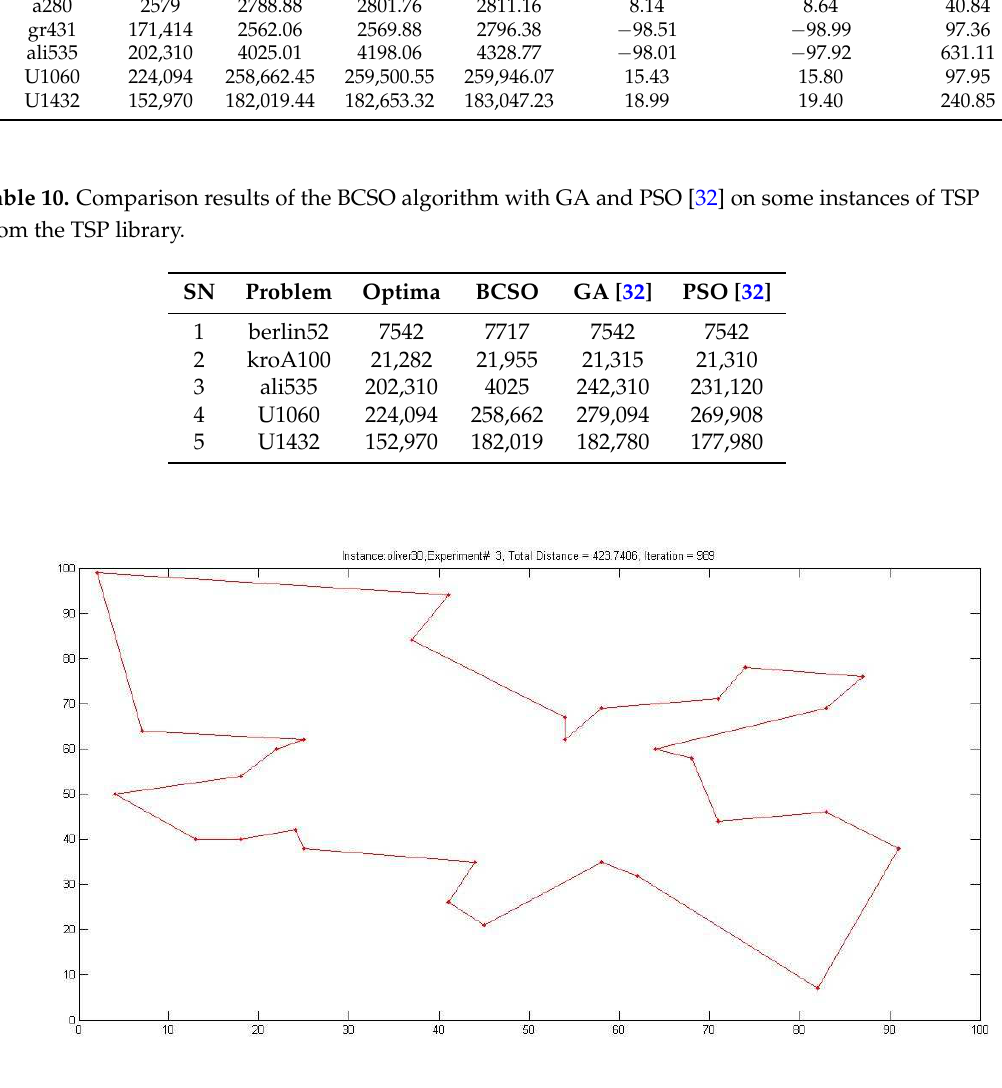
Figure 1. Graph illustrating one of the experiments on the Oliver 30 instance of TSP (containing 30 cities) solved by the proposed BCSO